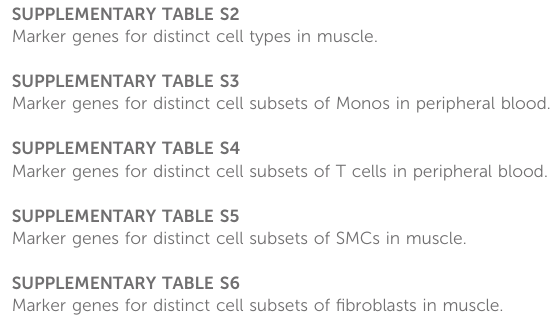
SUPPLEMENTARY TABLE S5 Marker genes for distinct cell subsets of SMCs in muscle. SUPPLEMENTARY TABLE S6 Marker genes for distinct cell subsets of fi broblasts in